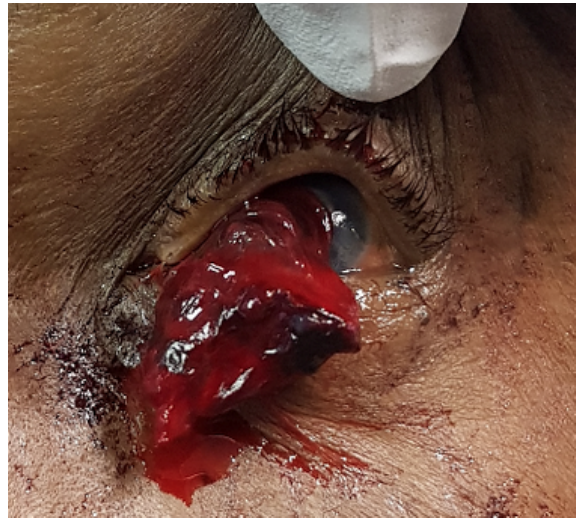
Figure 1: Haemorrhage extending from the cornea of the left